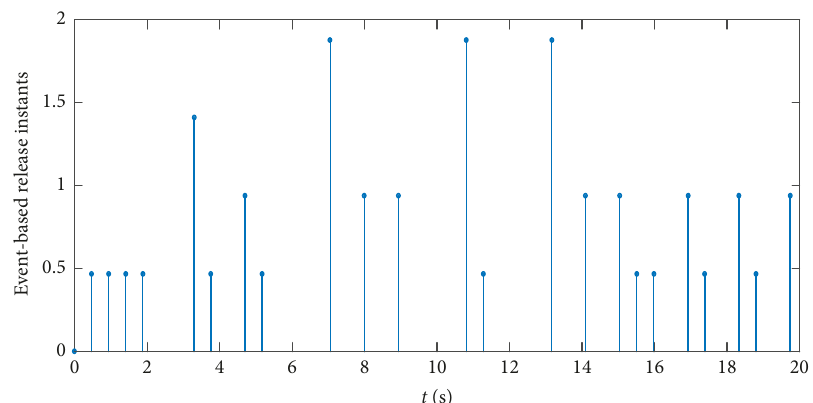
( t ) and the release instants. k